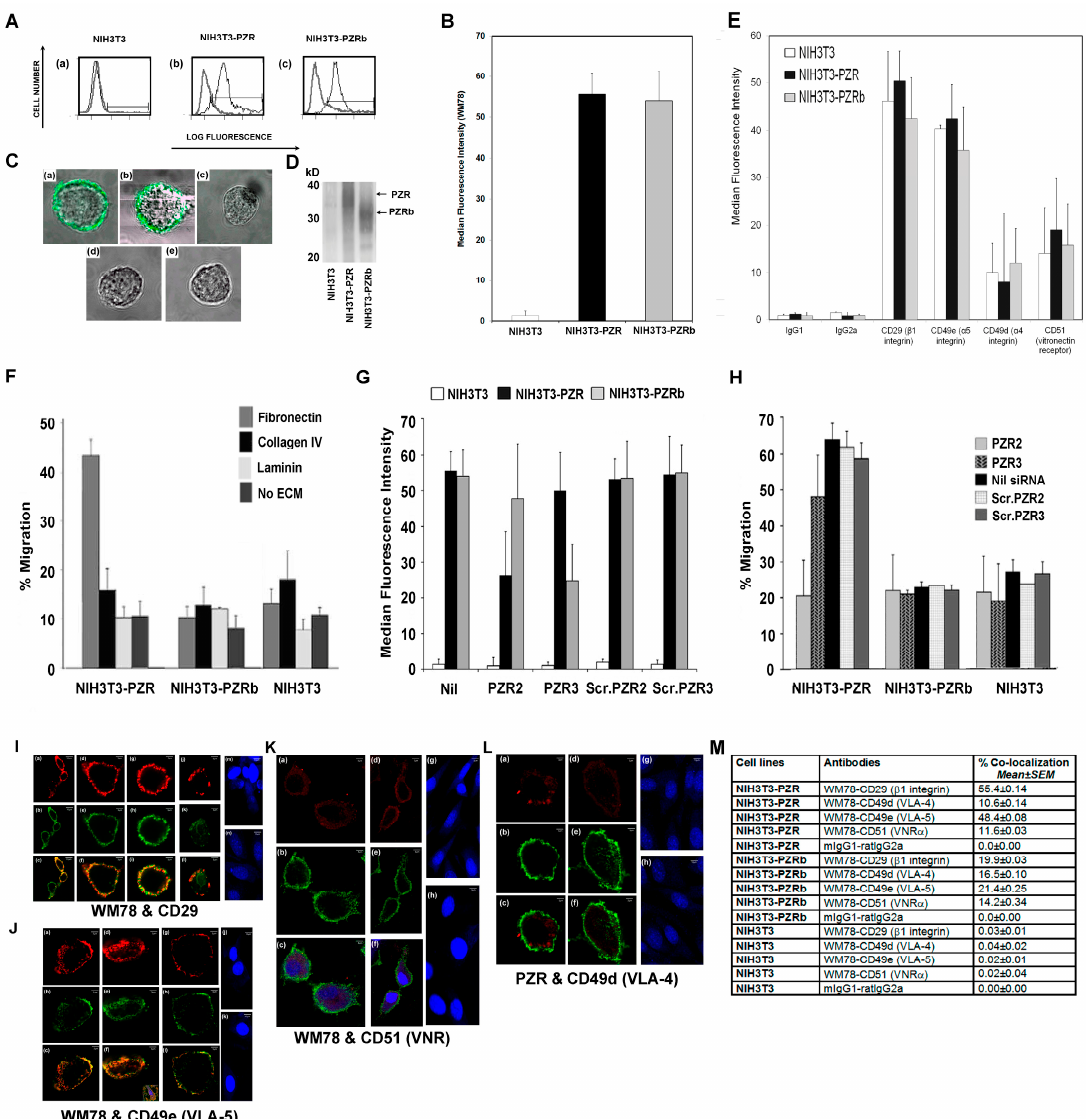
Figure 3. Human PZR regulates the migration of murine NIH3T3 ‐ PZR transfectants on fibronectin. ( A ) Flow cytometric histograms showing the level of expression of human PZR and PZRb as analyzed using WM78 plus FITC ‐ goat anti ‐ mIgG1 staining of NIH3T3 ( a ), NIH3T3 ‐ PZR ( b ), and